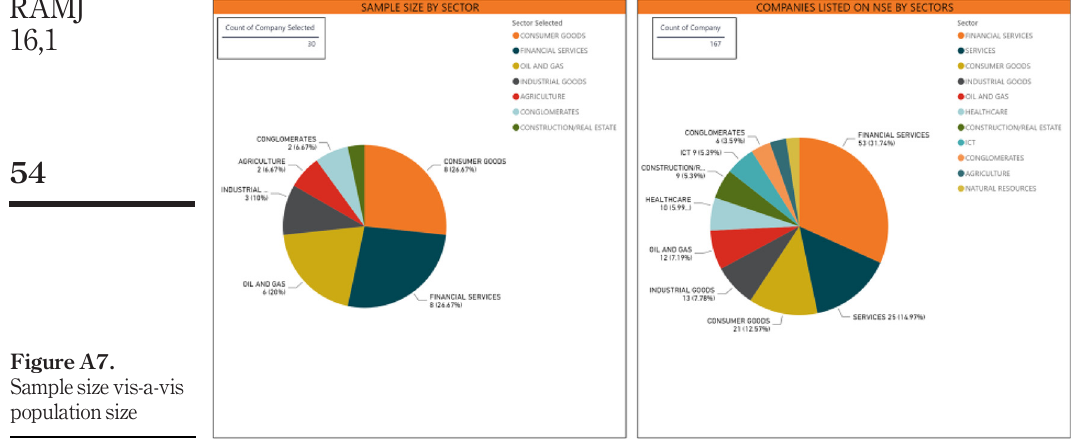
Figure A7. Sample size vis-a-vis population